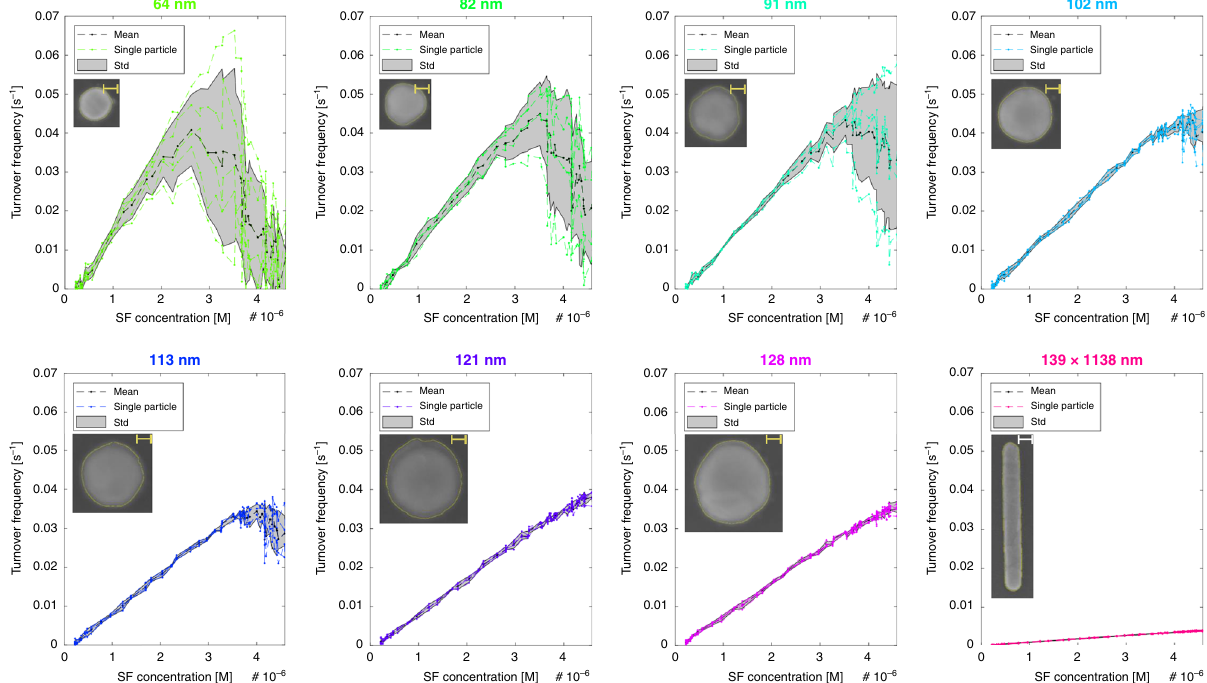
Fig. 3 Summary of single particle-speci fi c and mean turnover frequencies (ToFs) for 32 nanoparticles. All particles were addressed simultaneously in a single experiment at different nominal incoming fl uorescein concentrations. The titles display the nominal particle diameters and the insets show SEM images of corresponding particle analogs taken after the cleaning step on an open surface. The scale bars are 20 nm in all insets except for the 139 × 1138 nm patch where it is 100 nm. Black and colored lines display mean and individual particle ToFs, respectively, and the gray shaded areas depict the standard deviation. The fl uorescein concentration was systematically varied between 0 and 4.6 µ M and the borohydride concentration was kept